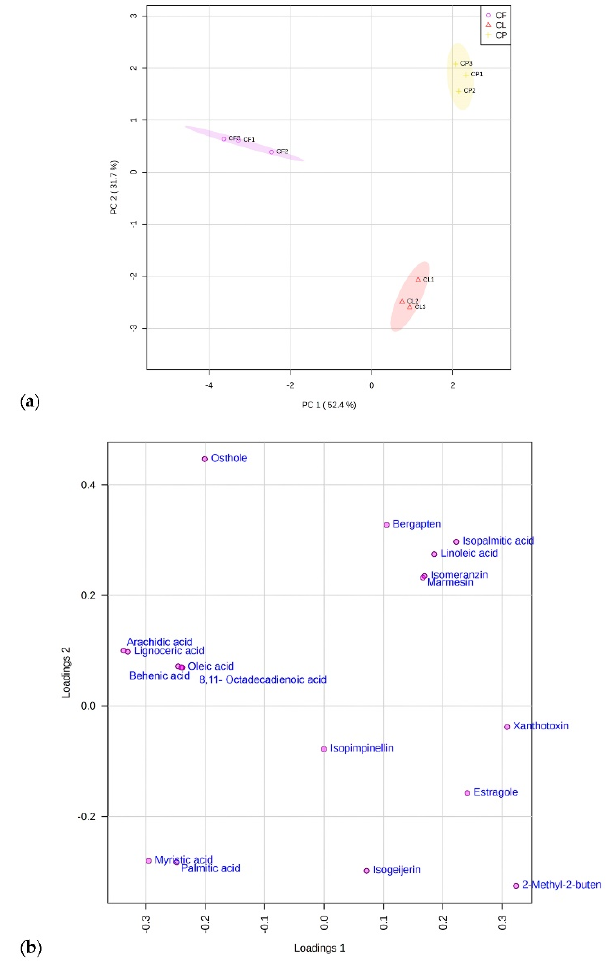
Figure 1. Scores ( a ) and loading plots ( b ) generated using the first two principal components (PC1 vs. PC2).